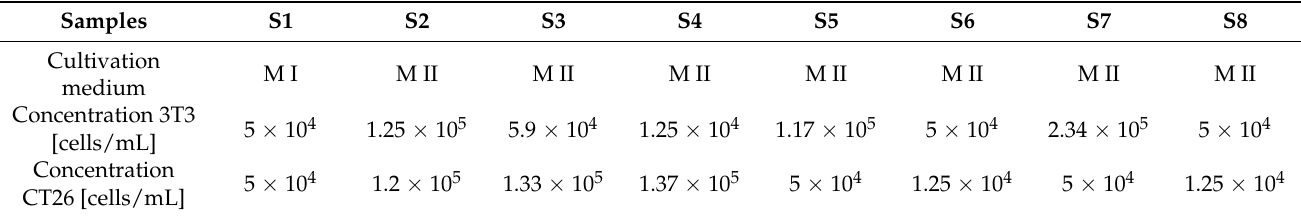
Table 1. Cell concentrations in samples S1–S8 (measured at pH =